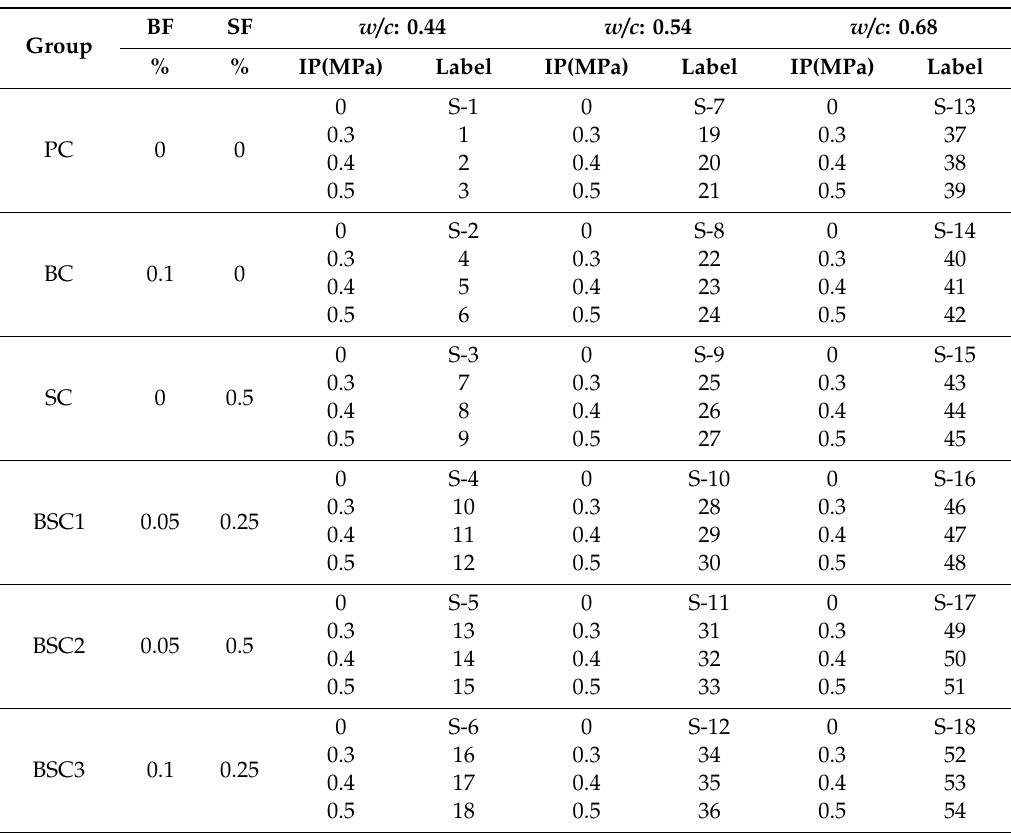
Table 3. Test conditions of basalt-macro synthetic polypropylene fiber reinforced concrete (BSFRC) specimens.